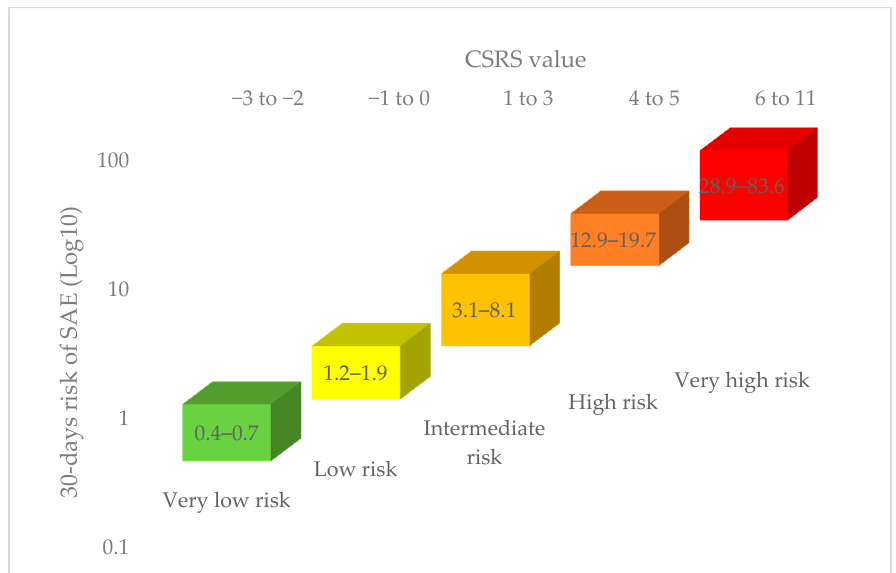
Figure 1. Risk prediction at 30 days from emergency evaluation based on CSRS value and risk category [43]. CSRS: Canadian Syncope Risk Score, SAE: serious adverse events.